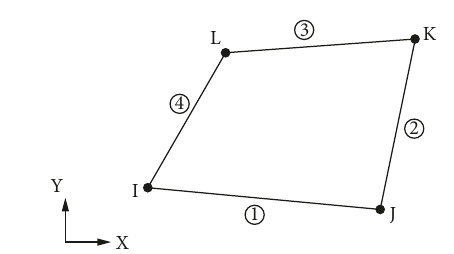
Figure 5: Finite element used in the analysis